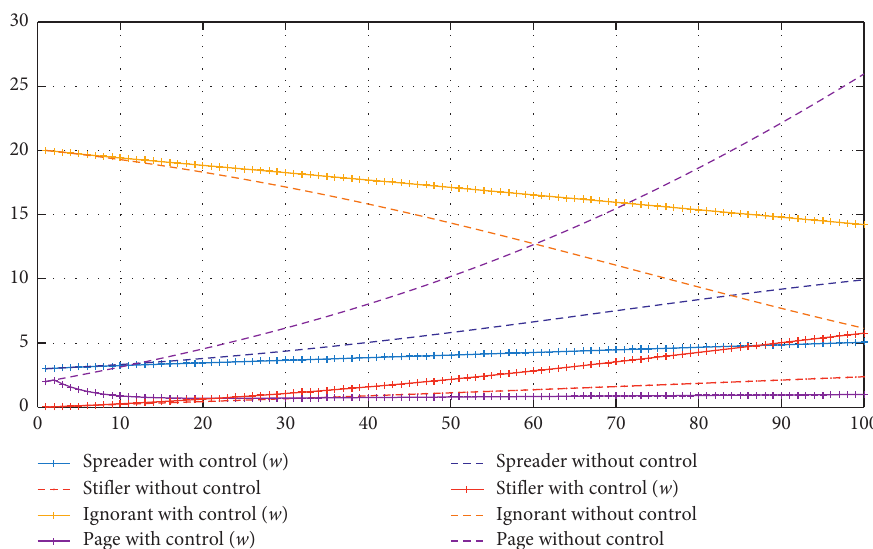
Figure 6: Dynamics with control w